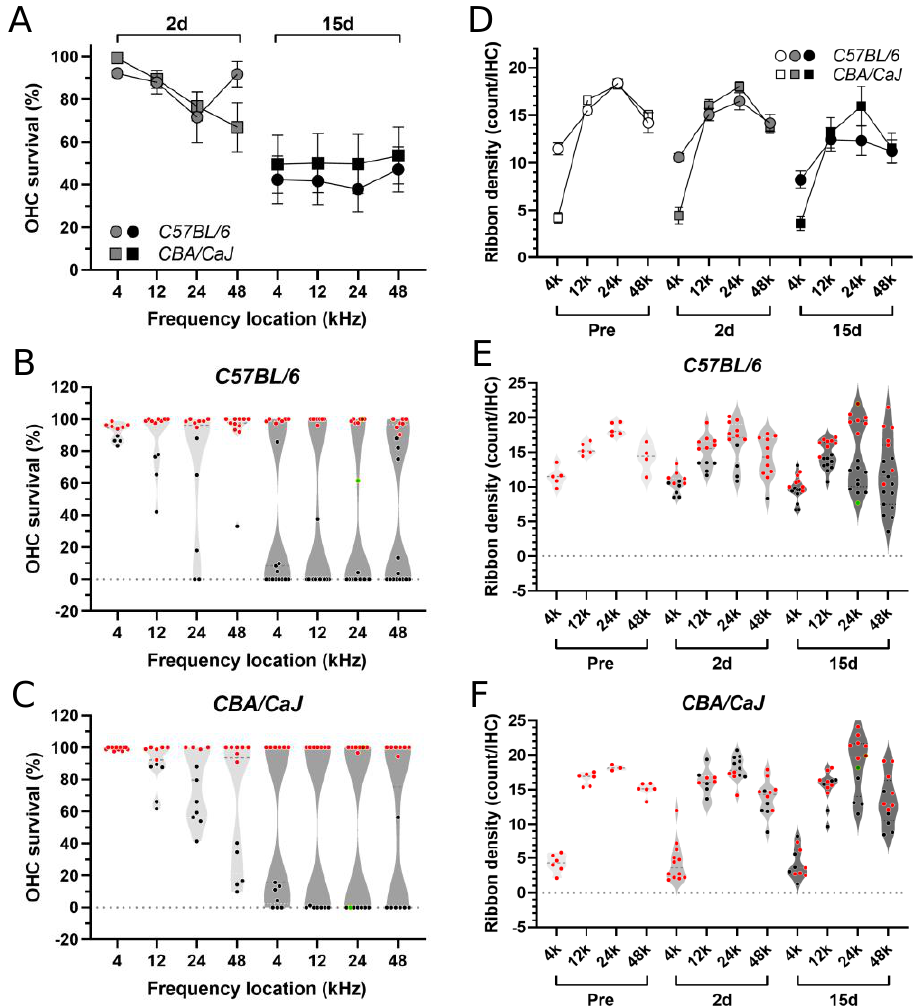
Figure 2. OHC survival and synaptic ribbon density after 400 G/200 F treatment. ( A ): Average percentages of OHC survival at multiple frequency locations 2 and 15 days after treatment in B6 (circles) and CBA (squares) mice. Error bar = SEM. ( B ): Violin plots of OHC survival from individual B6 mice. Red symbols indicate a survival rate ≥ 90%. ( C ): Violin plots of OHC survival from individual CBA mice. ( D ): Average ribbon density 2 and 15 days after the treatment in B6 and CBA mice. Error bar = SEM. ( E ): Violin plots of ribbon density from individual B6 mice. ( F ): Violin plots of ribbon density from individual CBA mice. Red symbols indicate the OHC survival rate ≥ 90% from the same cochlear sample analyzed.